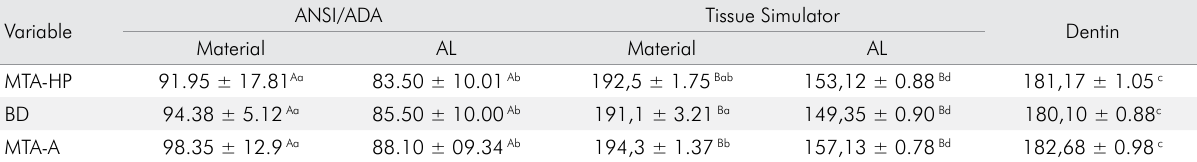
Table 2. Means and standard deviation of MTA-HP, BD, and MTA-A radiopacity (in grayscale pixel) (n = 10 per group).